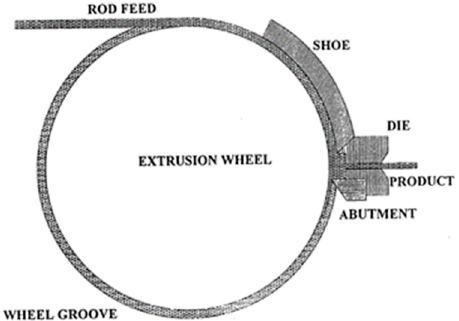
Figure 1. Schematic diagram of the conform.